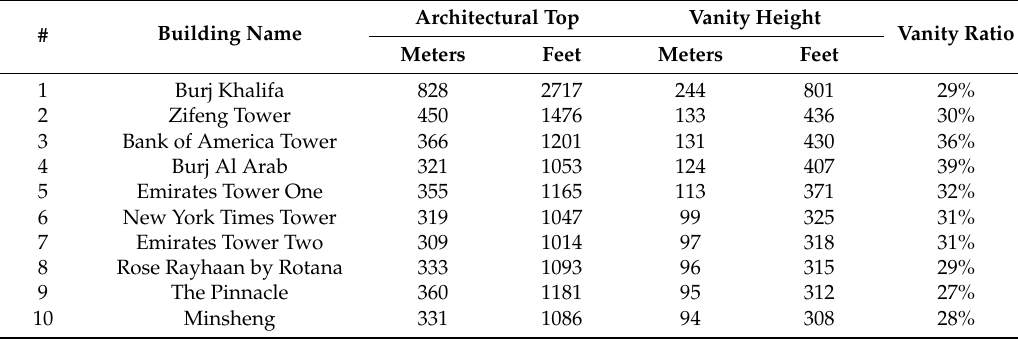
Table 4. World’s tallest vanity height as of July 2013